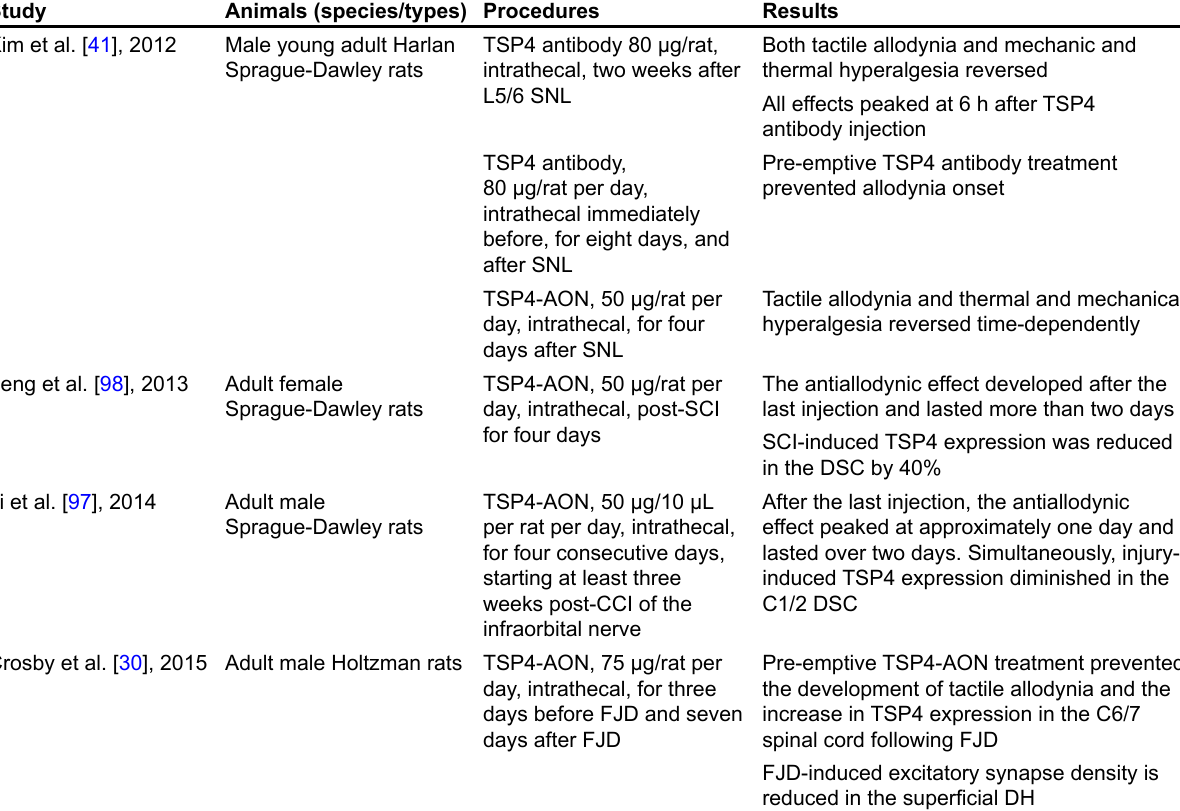
Table 2. Inhibition or blockage of TSP4 expression through TSP4-AON or antibody reversed or prevented the development of behavioral